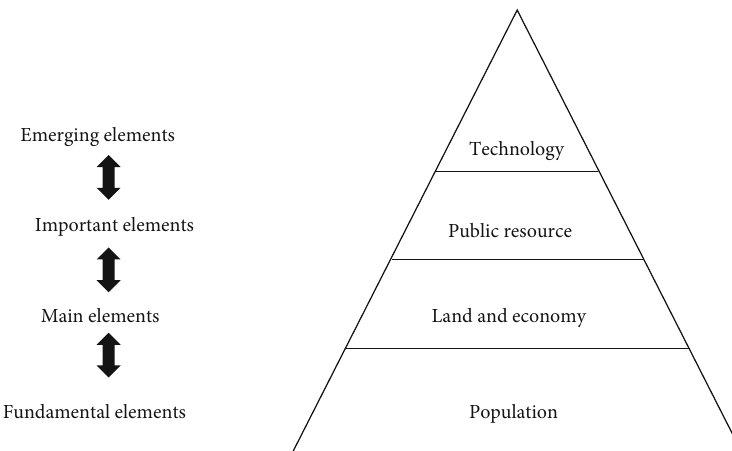
Figure 1: Pyramid of urban development factors (source: self-created).